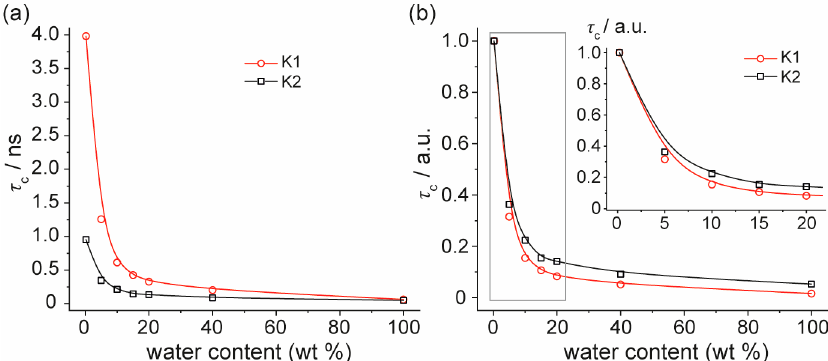
Figure 4. ( a ) Rotational correlation time τ c of K1 and K2 radicals dissolved in [Bmim]BF 4 /water mixtures vs. water content. Values are obtained from simulations of CW EPR spectra shown in Figure 3. ( b ) Values of τ c normalized to 1 at zero water content. Color lines are guides for the eye.